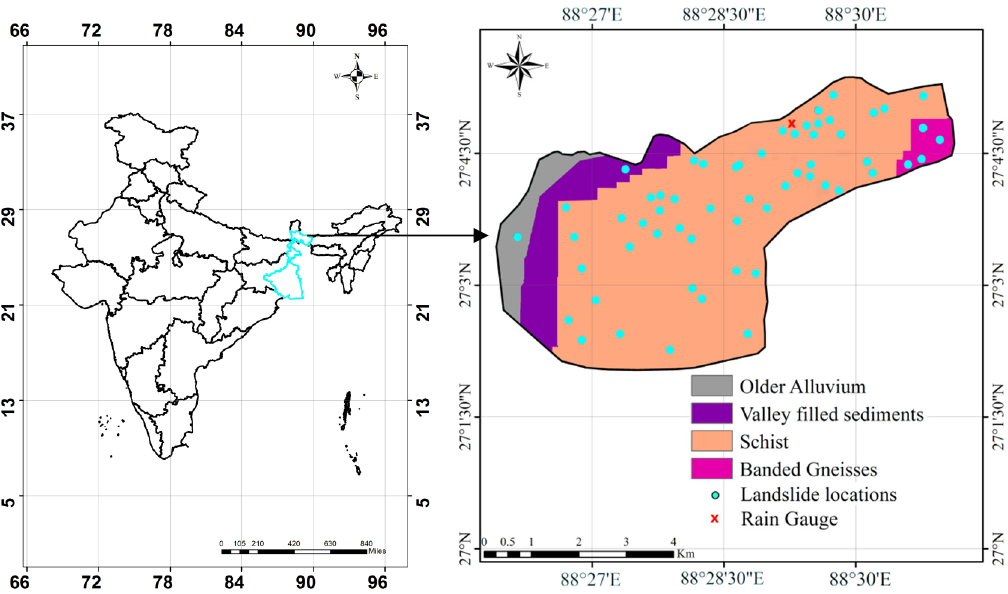
Figure 1. Location of the study area along with a hydrogeological map of the region.